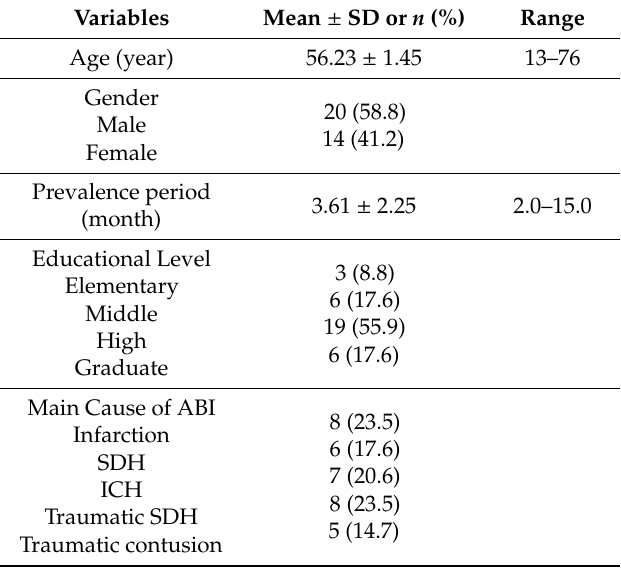
Table 1. General characteristics of participants ( n =